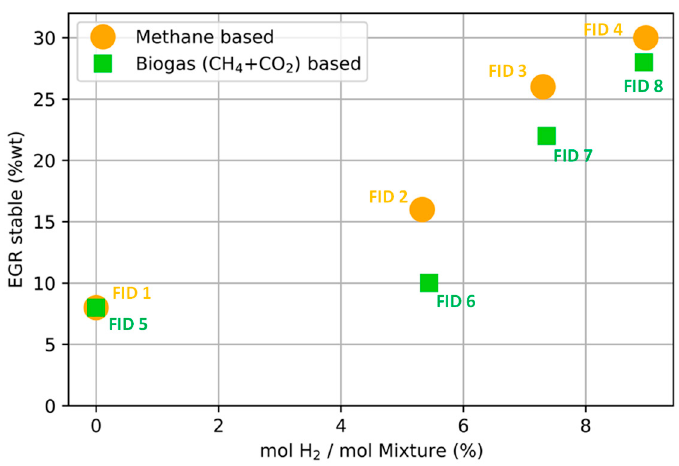
Figure 5. Comparison of the increasing EGR stable allowed by increasing the fraction of hydrogen in methane (orange marker) and biogas (green marker). Each marker reports a progressive number as a Fuel Identification number (FID).